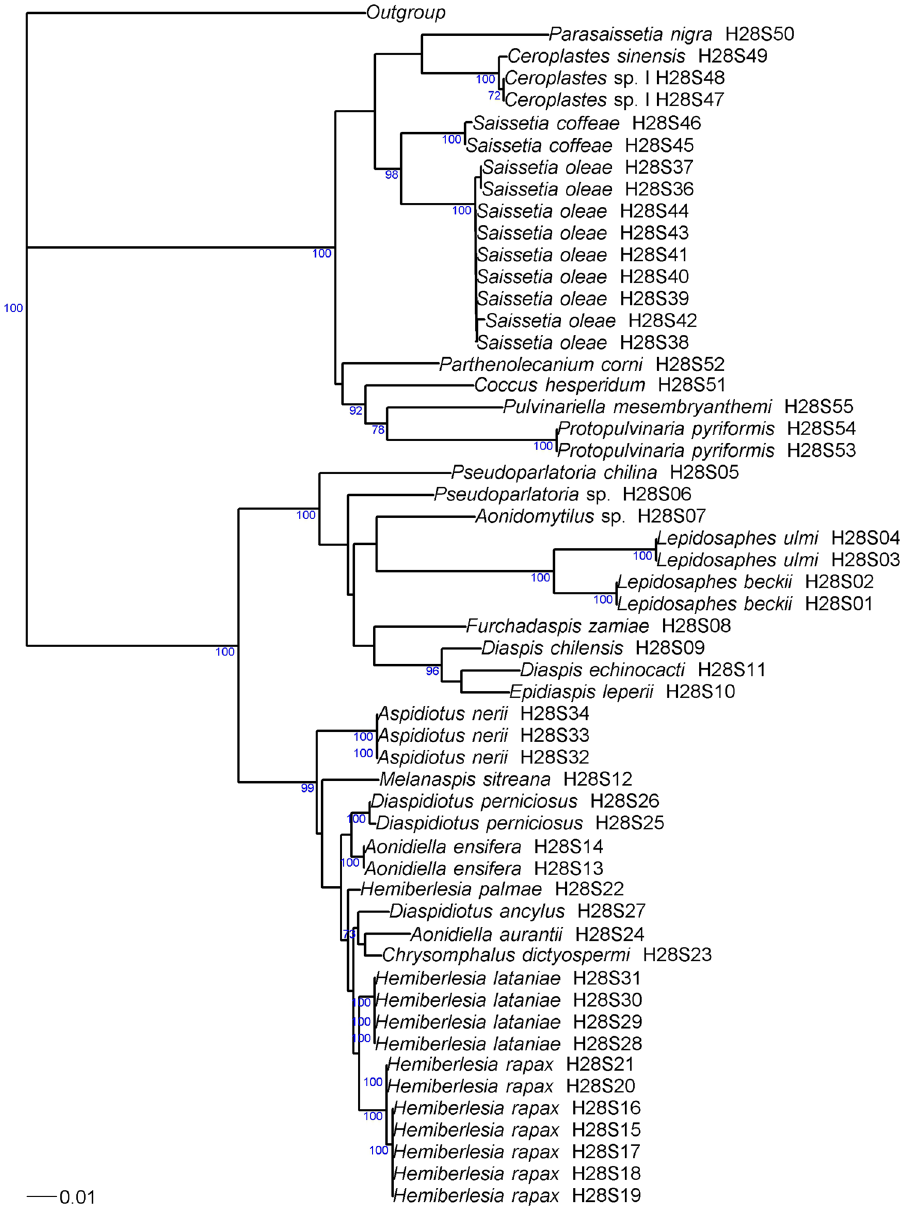
Figure 2. Phylogenetic relationships between 54 haplotypes of Coccidae and Diaspididae based on 28S sequences analyzed by neighbor-joining, with the K2P distance model, and Pseudococcus viburni (Hemiptera: Pseudococcidae) (GenBank accession: KU499443) as the outgroup. Bootstrap values below 70% are not